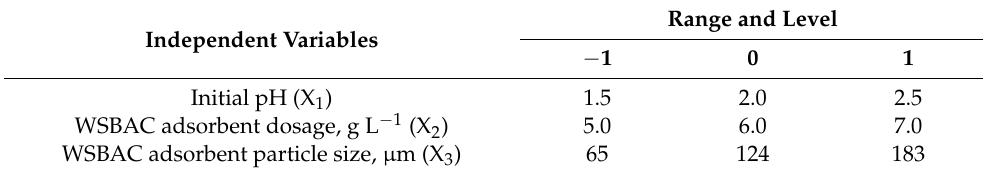
Table 2. Experimental range and levels of various process parameters for RBBR dye removal by WSBAC